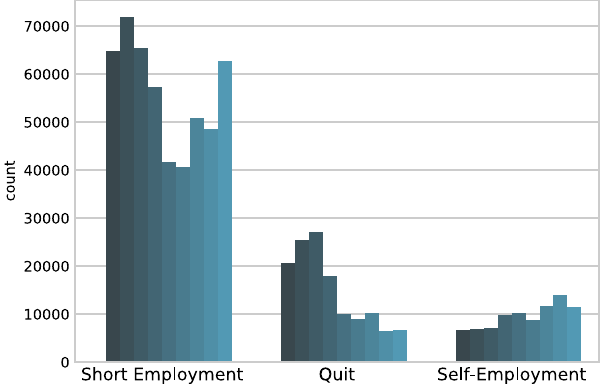
Fig. 25 STU expanded spells by type by year. Notes Each bar represents a year, from 2004 to 2013 (both inclusive). Raw number of unemployment spells, STU expanded, by